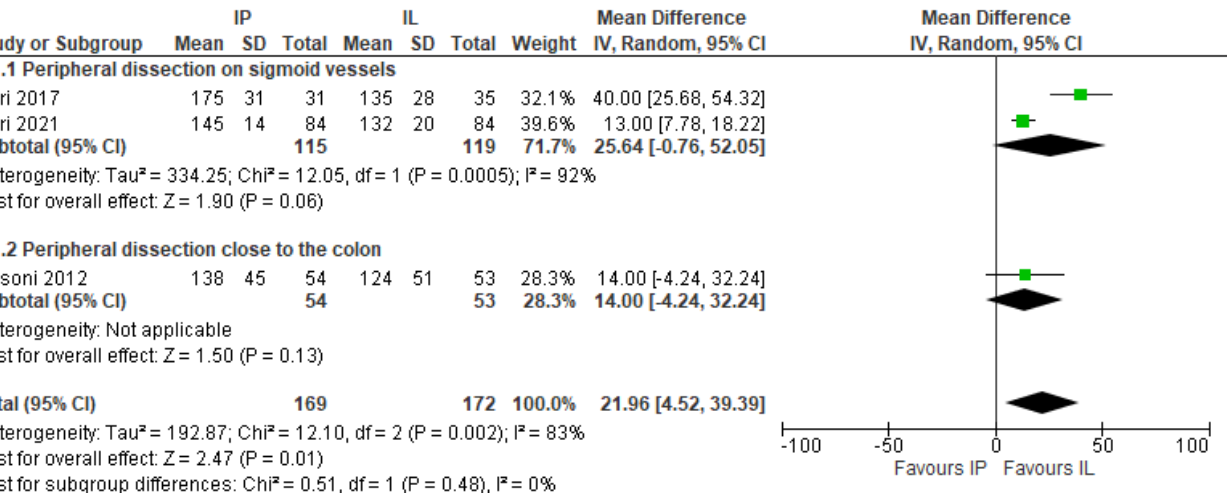
Figure 8. Operative time, risk ratio.